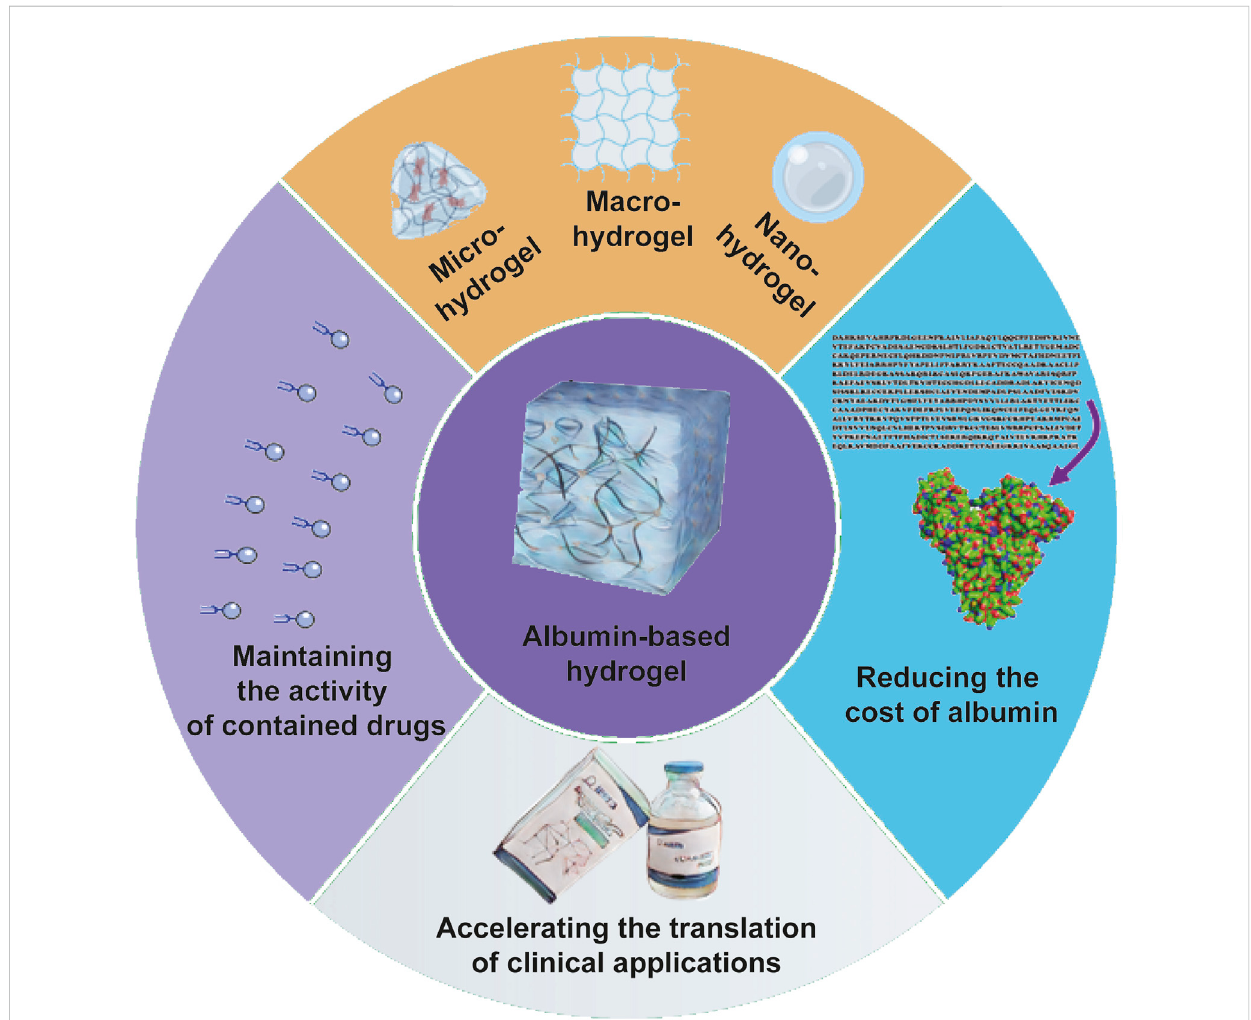
FIGURE 3 Potential directions for future research ofalbumin-based hydrogels. Thereare mainly fourpotential research directions. Firstly, theactivityof drugs, especially biomolecules, such as growth factors, protein inhibitors, etc., should be retained to the maximum extent during the preparation of albumin- based hydrogels. Second, other solutions need to be found to minimize the cost of producing albumin and even preparing albumin-based hydrogels. Such as development of recombinant HSA, enhancing the utilization of ovalbumin, etc. Third, various sizes of albumin-based hydrogels should be developed to meet the needs of clinical applications. The last, the translation of research on albumin-based hydrogels to clinical applications is still